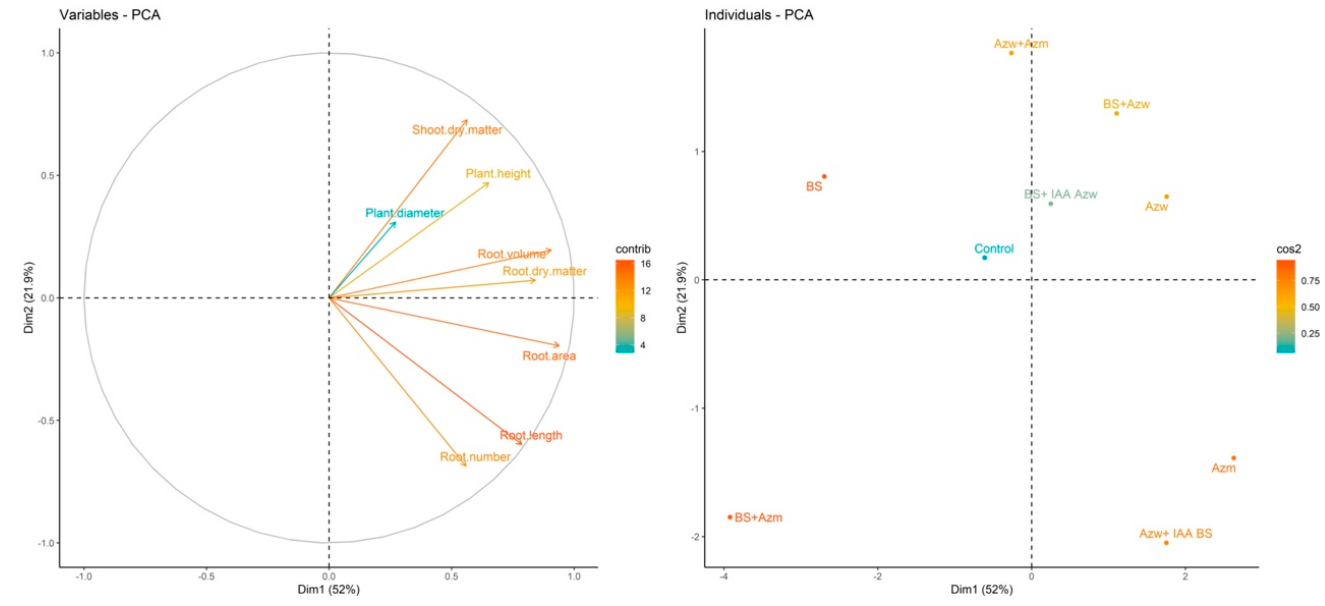
Figure 2. Main component analysis (PCA) for variables and treatments (individuals). Values on Axes 1 and 2 represent the percentage of total variance explained by axes for the Micro-Tom genotype.